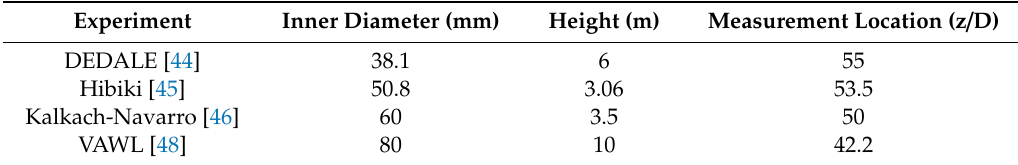
Table 3. Air-water bubbly flow experiments used to evaluate the bubble size correlation.